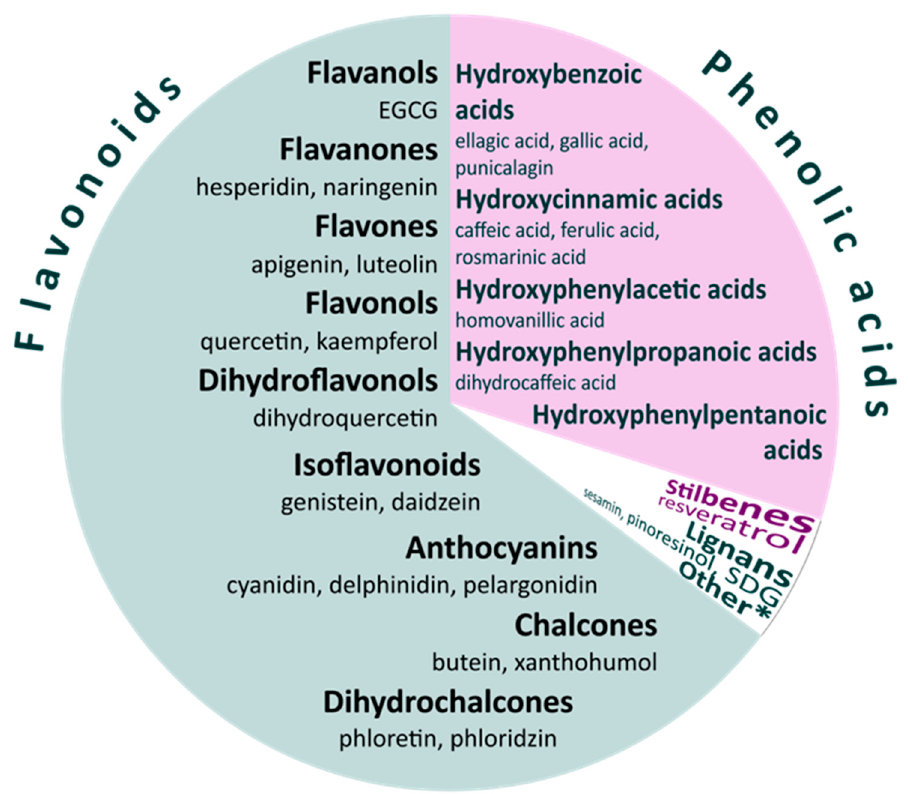
Figure 1. Main classes and subclasses of dietary polyphenols. Flavonoids make approximately two-thirds of total polyphenol intake; phenolic acids account for the remaining one-third. * Other polyphenols are alkylmethoxyphenols, alkylphenols, curcuminoids (curcumin), furanocoumarins (psoralen), hydroxybenzaldehydes (vanillin), hydroxybenzoketones, hydroxycinnamaldehydes, hydroxycoumarins (coumarin, esculetin), hydroxyphenylpropenes (eugenol), methoxyphenols, naphtoquinones, phenolic terpenes (carvacrol, thymol), tyrosols (hydroxytyrosol, tyrosol, oleuropein). EGCG—epigallocatechin-gallate; SDG—secoisolariciresinol diglucoside.